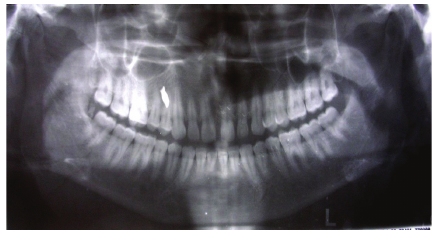
Figure 5: An OPG showing the copper strip.